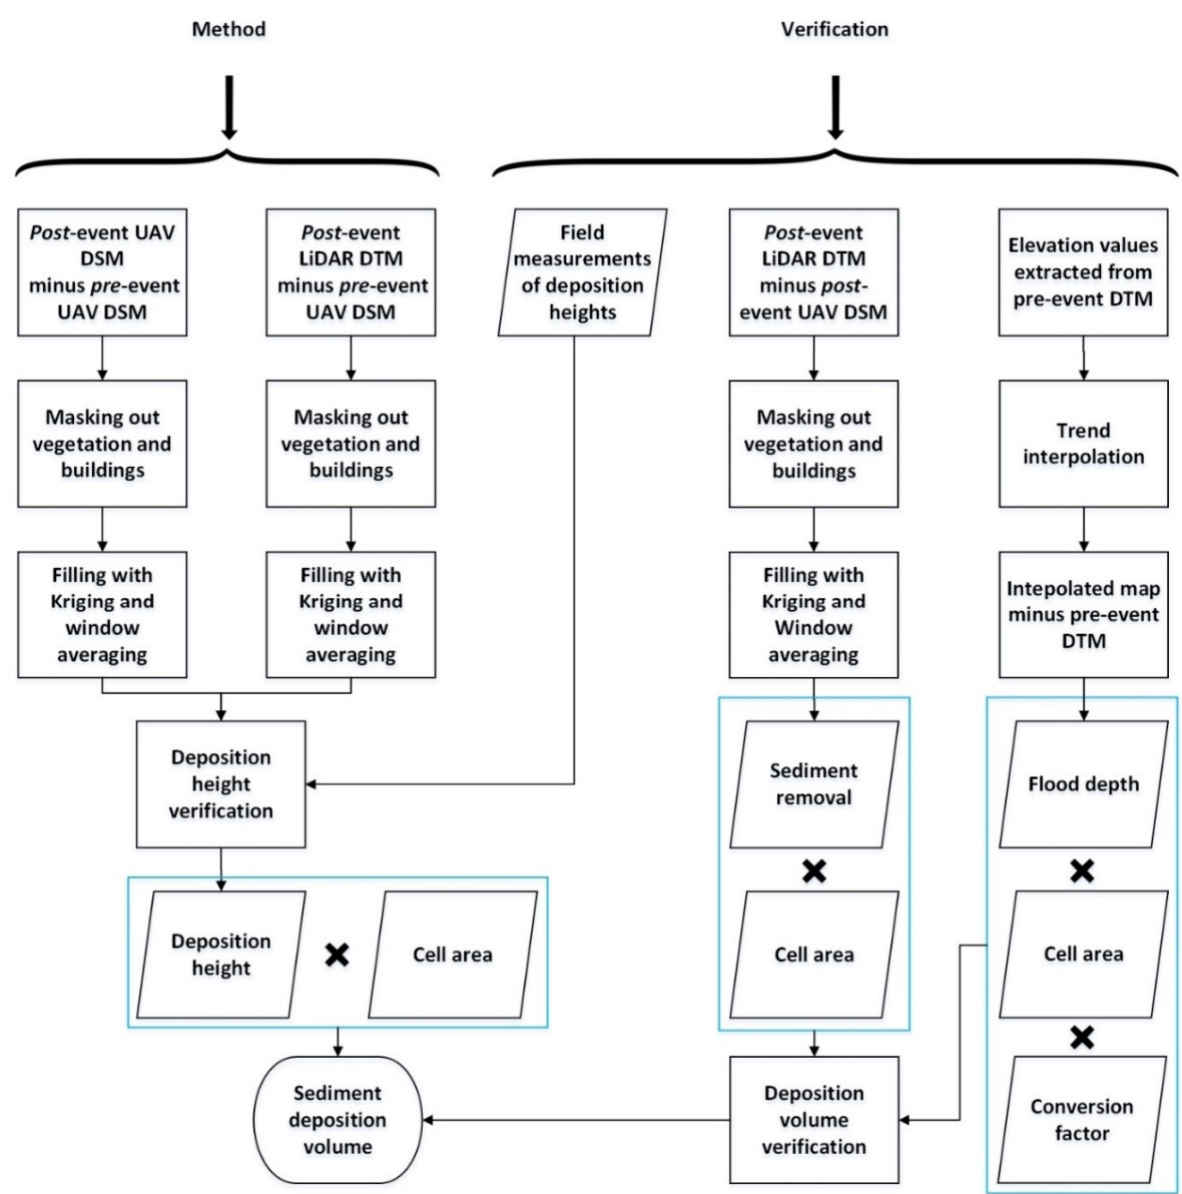
Figure 3. Schematic representation of research methodology. Specifications of pre- and post-event UAV DSM and LiDAR DTM are given in Table 2.